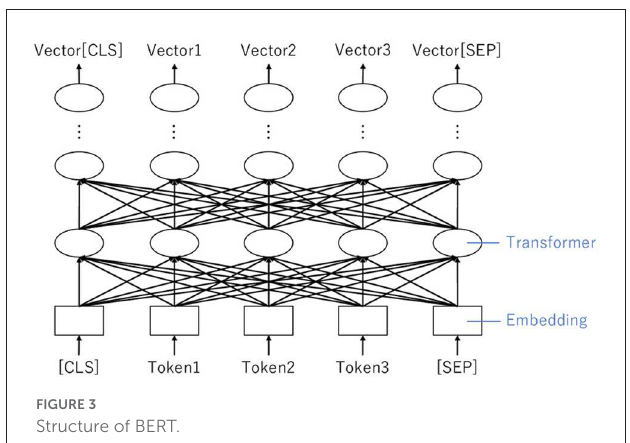
FIGURE3 Structure of